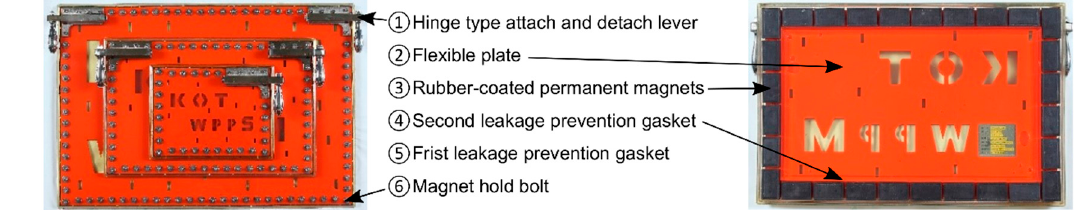
Figure 2. Magnetic-type liquid stop device (2017) [38].